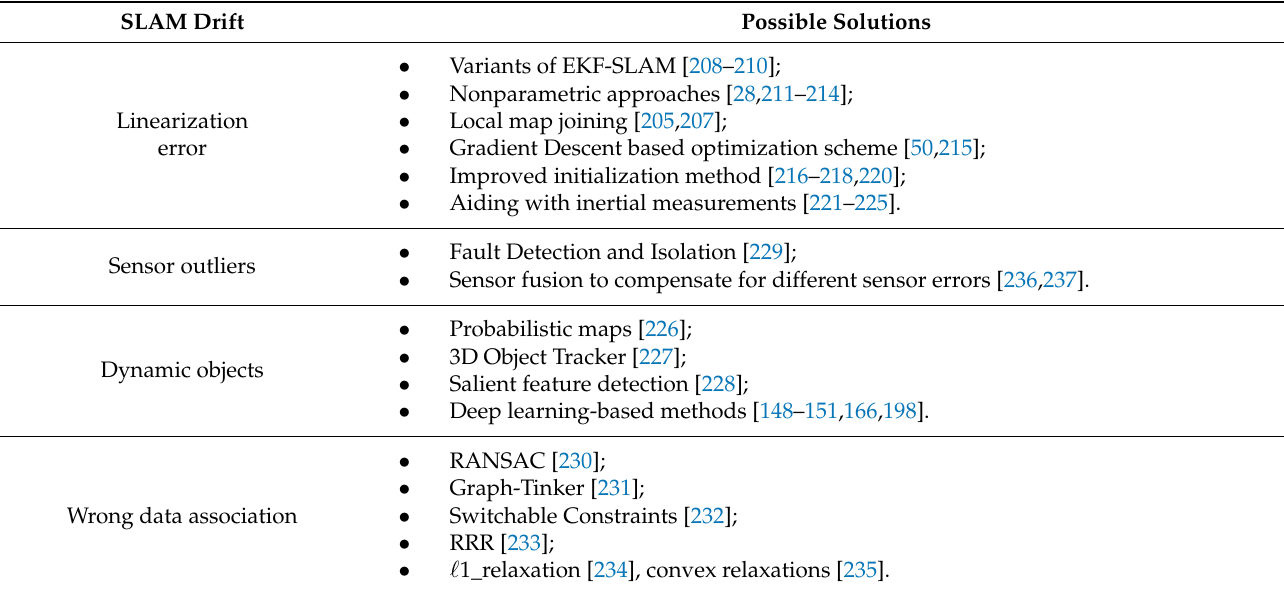
Table 2. Potential causes of SLAM drifts and